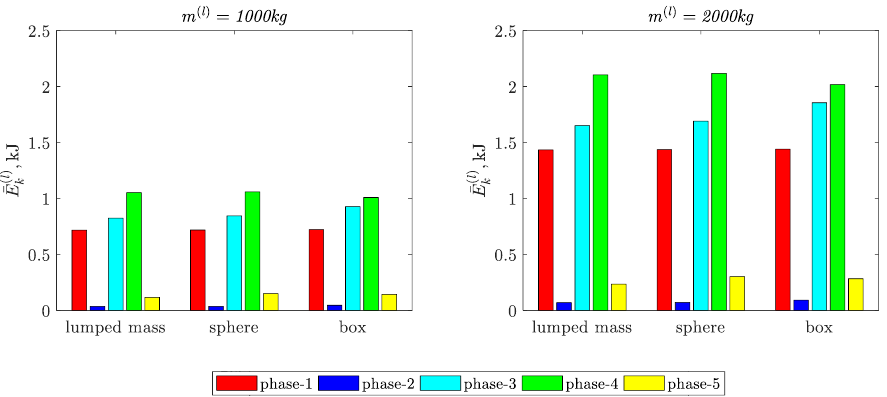
Figures 7 and 8 present the values of the indicators defined by Equation (6).